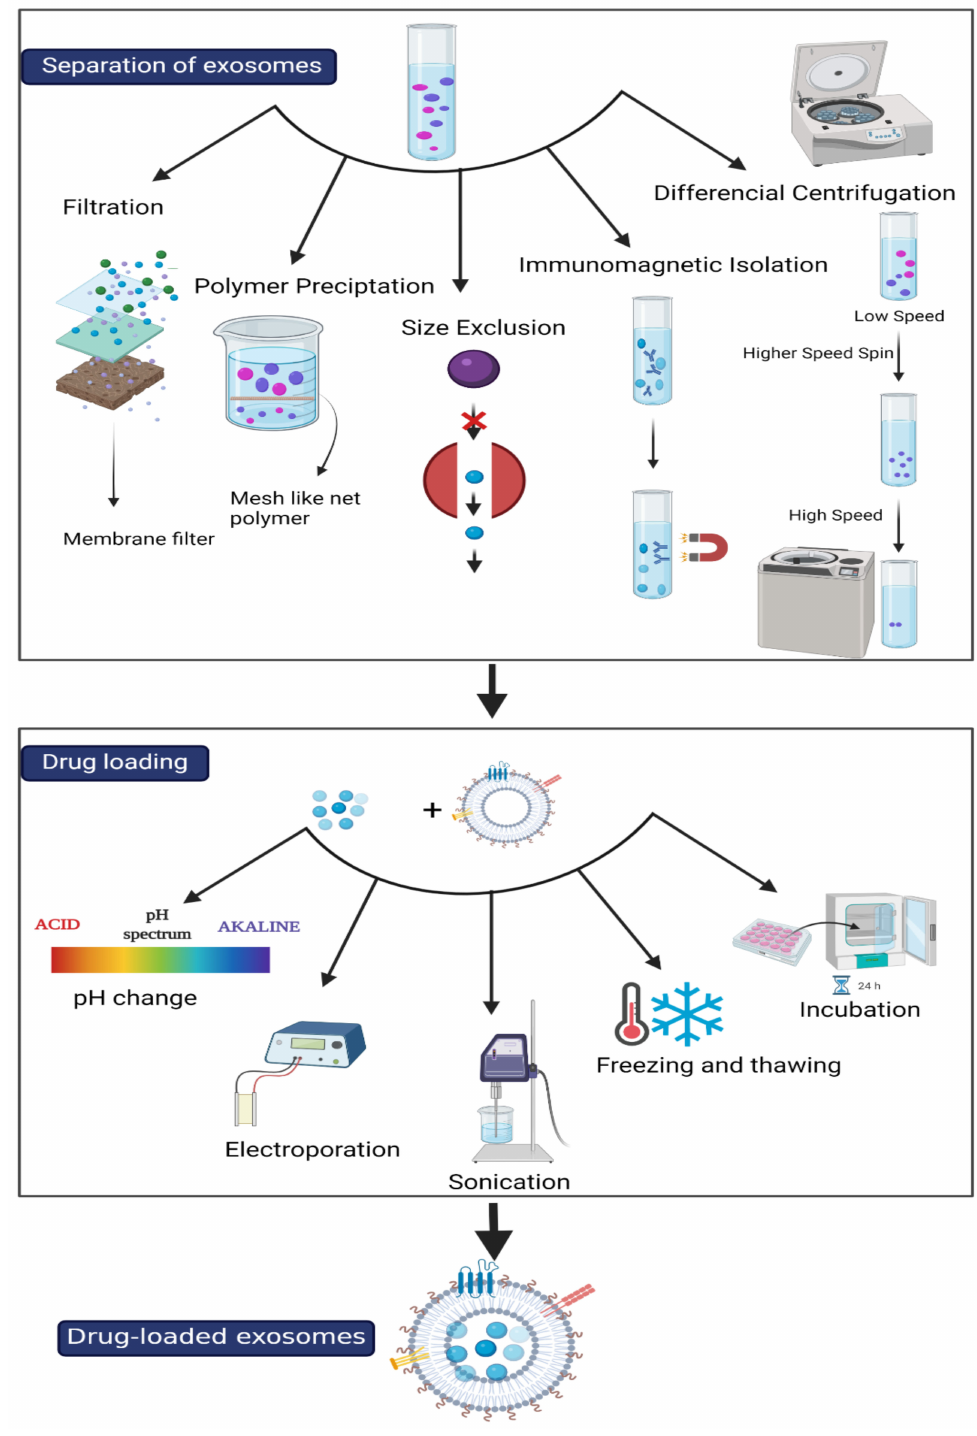
Figure 2. The separation and drug loading techniques for exosomes. 475 × 872 mm (118 × 118